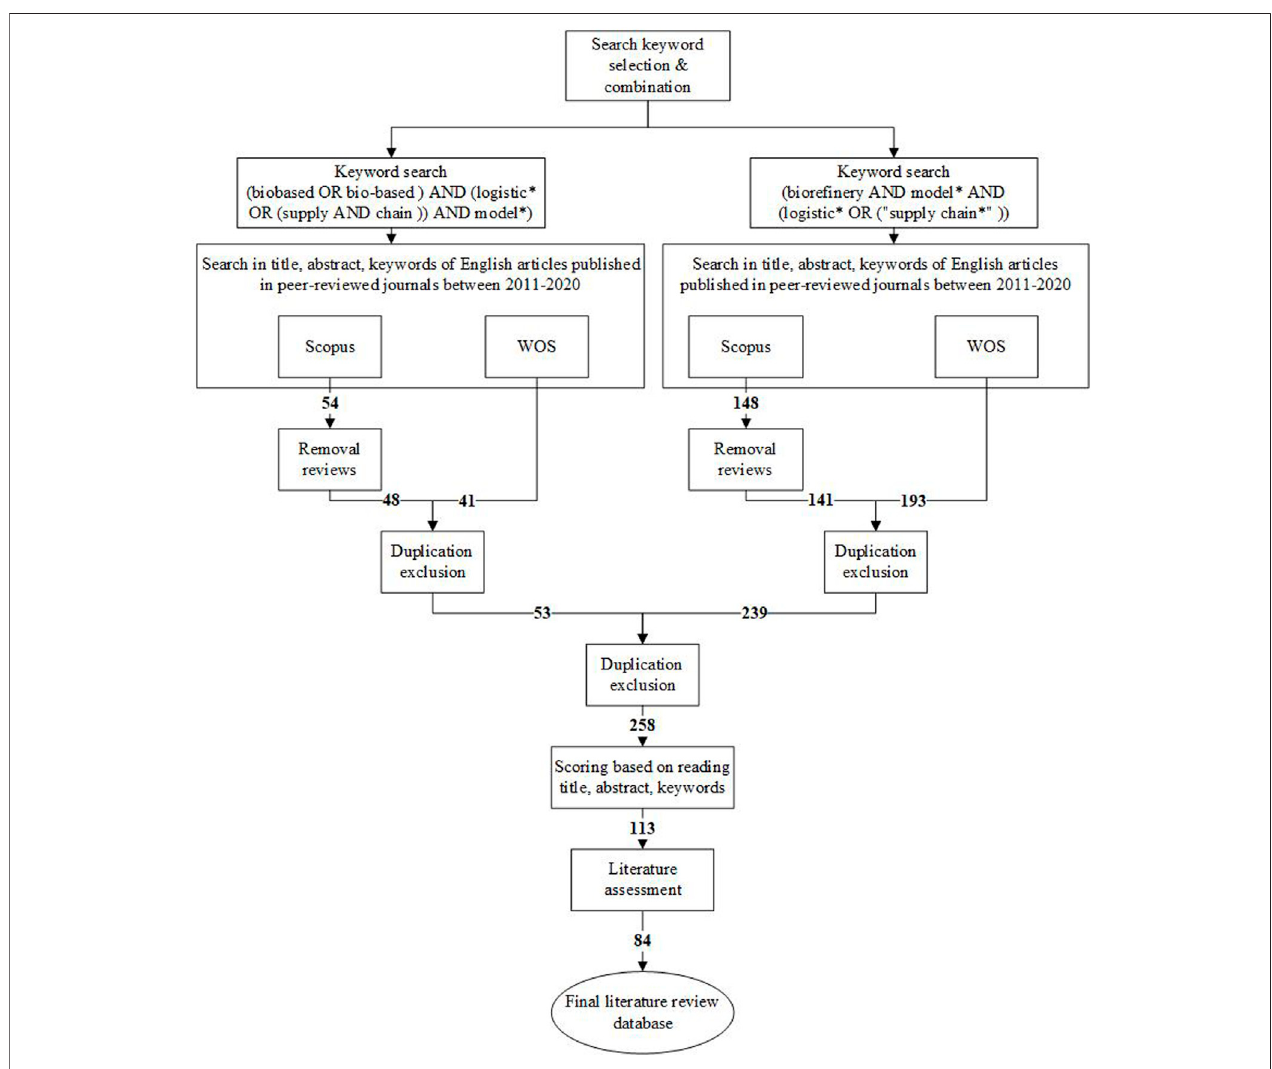
FIGURE 3 | Literature search and re fi nement